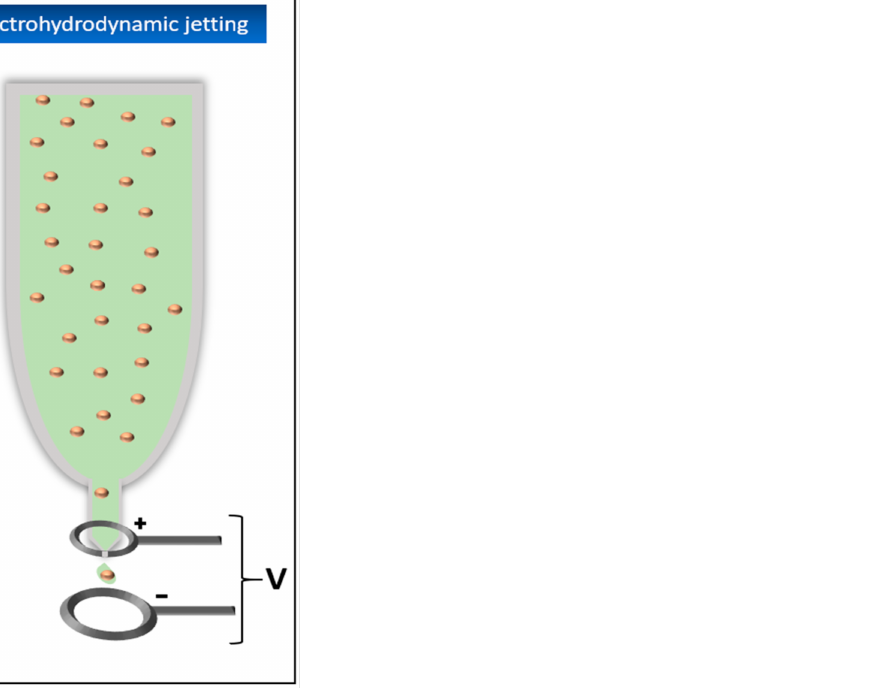
Figure 9. Schematic representation of the electrodynamic jetting. The printing material is sprayed out of the nozzle with the application of an electric